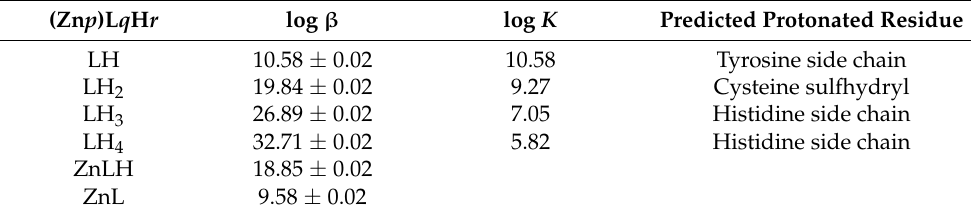
Figure 6. CD spectra of ZnT8c with Ni 2+ excess. ZnT8cR + 0.1 mM NiSO 4 (black line) and ZnT8cW + 0.1 mM of NiSO 4 (dotted line) in 50 mM Tris, 300 mM NaCl, 100 mM sucrose, 100 µ M TCEP, pH 8, 10 mm pathlength. The concentrations of the ZnT8c proteins were 35 µ M. Corrected for buffer baseline. Table 6. Protonation constants (log β ) for the ZnT8 8-residue N-terminal peptide and stability con- stants (log β ) for its zinc(II)-peptide complexes, ionic strength 0.1 M (KNO 3 ), 25 ◦ C. The protonated residues in each species are predicted based on amino acid p K a